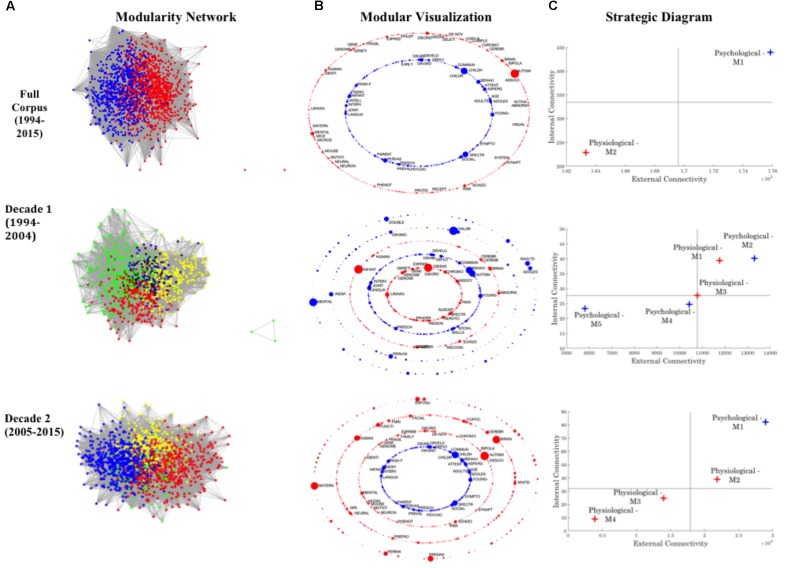
Summary of co-keyword analysis completed across the Full Corpus, and both Decades. (A) Keyword co-occurrence matrices are visualized using graph theory methods, and modularity analytics applied to identify self-clustering modules. These modules are initially visualized within the context of the overarching network, with each highlighted by a block color (e.g., two modules are initially identified at the full decade, while four are identified for Decade 2). (B) To aid accessibility, these modules are visualized as colored concentric rings, each reflecting a module’s singular rank and theme (Psychological: Blue; Physiological: Red; Green: Interdisciplinary). Node size reflects normalized Eigenvector centrality – with larger nodes having higher levels of normalized Eigenvector centrality, and thus, empirically assessed as dominant across the module; such prominent internal nodes are labeled (see Supplementary Section 1 for full node listing used for thematic coding). (C) Modular internal and external connectivity metrics were extracted, normalized, and visualized relative to the normalized corpus median values via a strategic diagram. Providing a summary of internal connectivity along the Y-axis, this provides a measure of the cohesiveness of a thematic trend – with highly developed and interconnected themes displaying higher levels of internal connectivity. Summative metrics on the X-axis provide an overview of external connectivity, demonstrating the central dominance of a theme to the research domain. The range of corpus internal and external connections display significant growth between Decade 1 and Decade 2, in line with research proliferation (see Figure 2), coupled with simultaneous constriction in modularity, perhaps indicative of the development of cohesive research themes (Figure 2D)—see Supplementary Table 4. For yearly (1994, 2006, 2015) assessment see Supplementary Figure 3. Further, for larger high resolution figures please see https://figshare.com/s/9a0f7b0839fef2df1a6e.